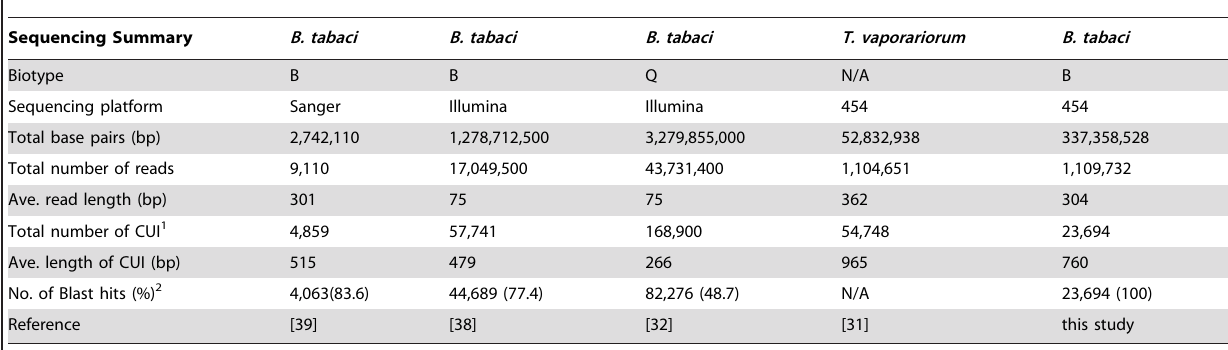
Table 5. Current available whitefly transcriptomes.